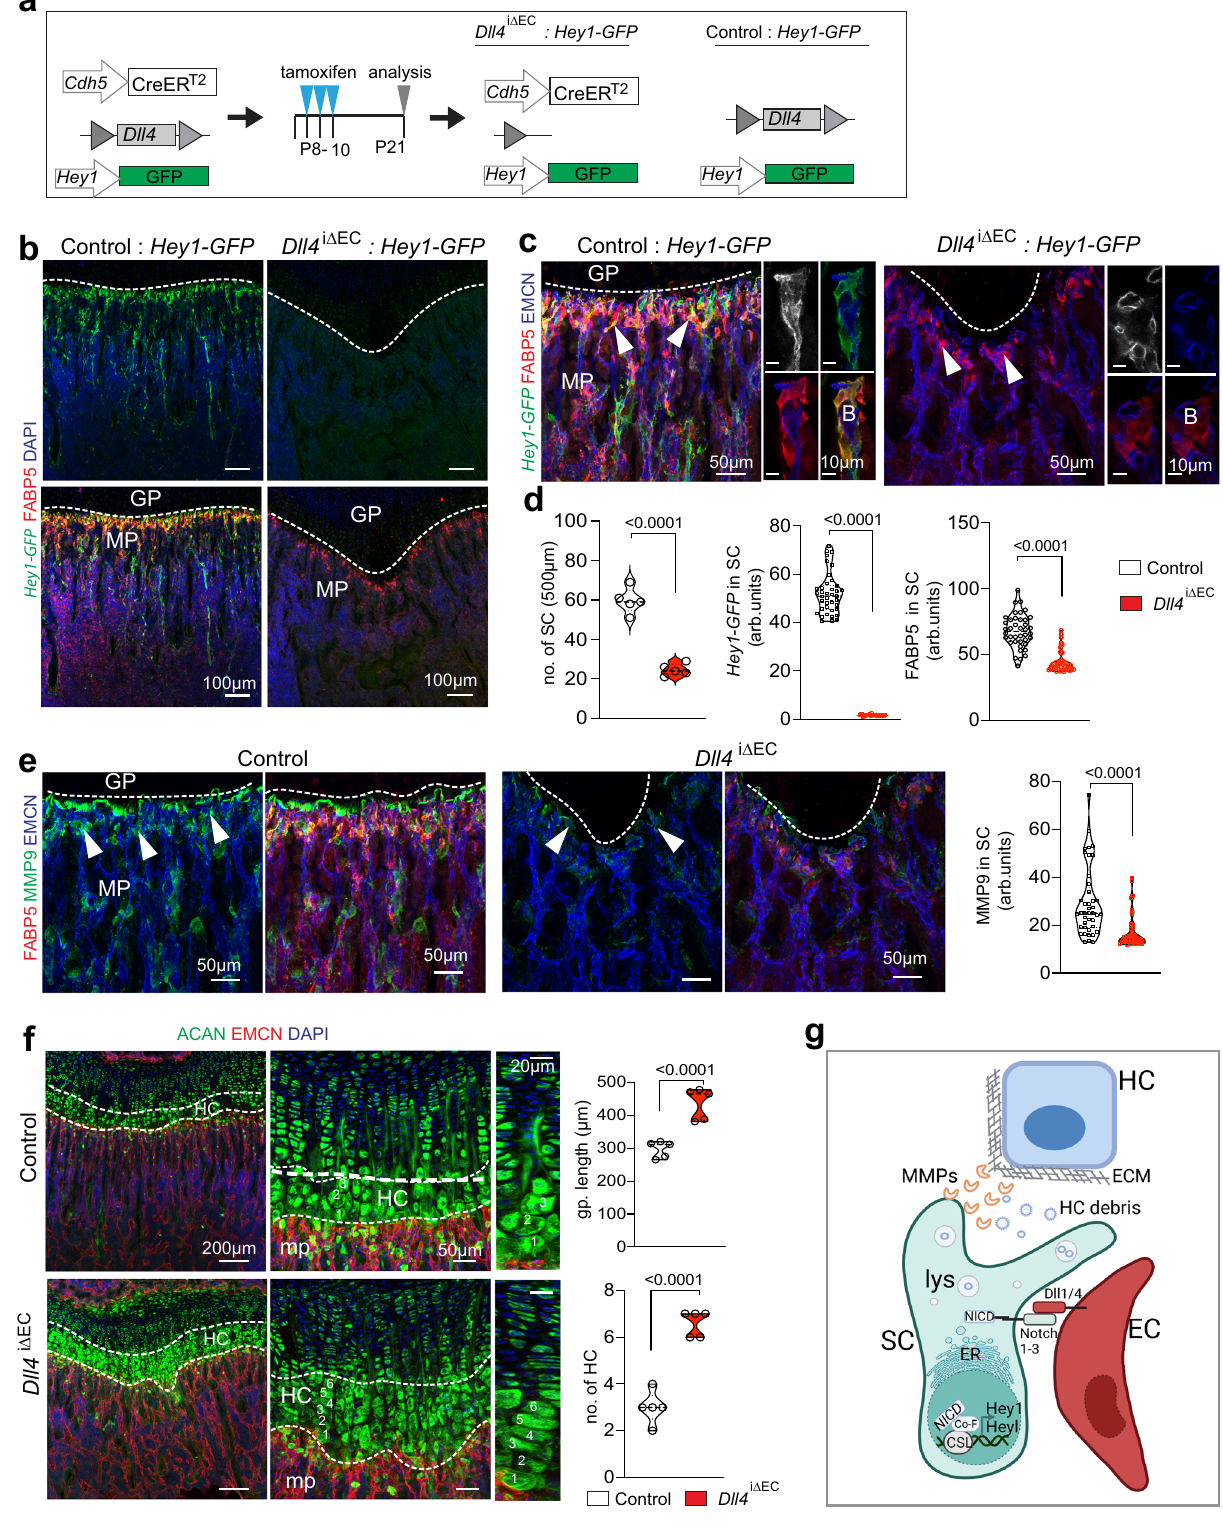
PBS for 10 mins at room temperature (RT). Samples were incubated in blocking solution (5% heat-inactivated donkey serum in 0.3% Triton-X-100) for 30 min at RT. Primary antibodies (rat monoclonal anti-Endomucin (V.7C7) (Santa Cruz, Cat# sc-65495, 1:100 dilution), goat polyclonal anti-CD31 (R&D, Cat# AF3628, 1:100 dilution), rabbit-polyclonal anti-Fabp5 (Lifespan Bioscience, Cat#C312991, 1:100 dilution), goat anti-Pdgfrb (R&D, Cat# AF1042, 1:100 dilution),